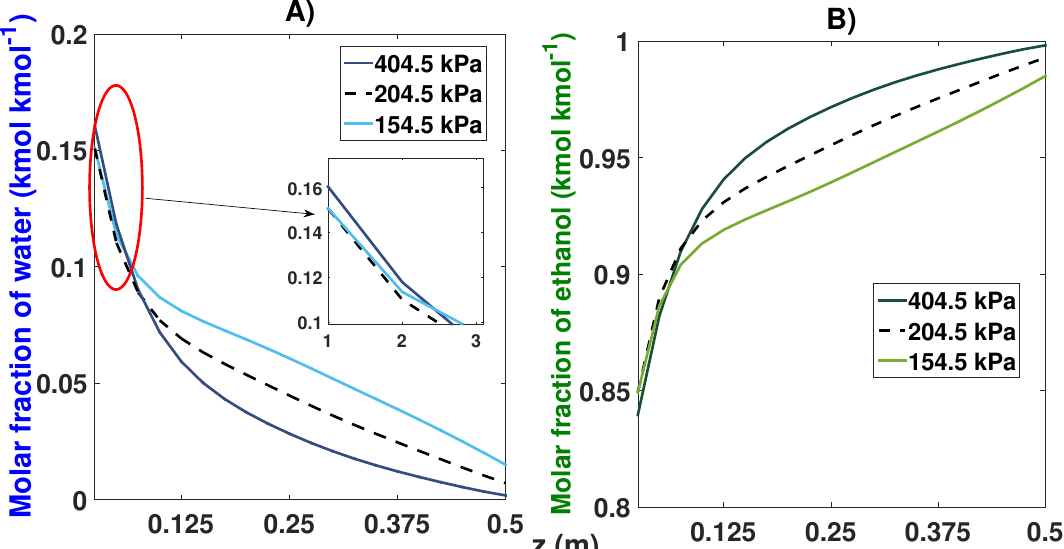
Figure 16. Molar fraction profile in the bed from the start-up and at CSS for three different feed pressures. ( A ) Effect of feed pressure on the molar fraction of water; ( B ) Effect of feed pressure on the molar fraction of